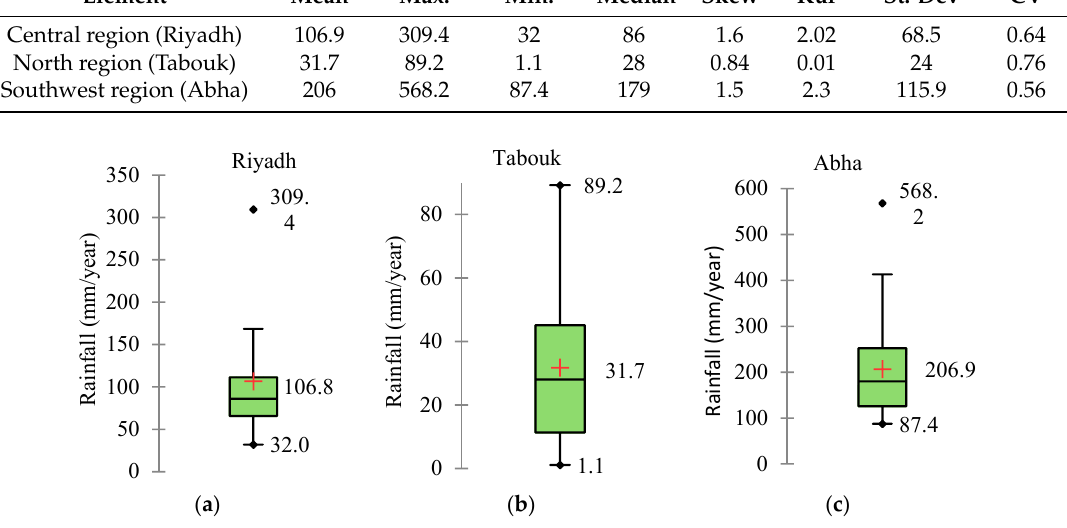
Table 2. Summary of rainfall in the central (Riyadh), north (Tabouk) and southwest (Abha) regions of Saudi Arabia. Element Mean Max.